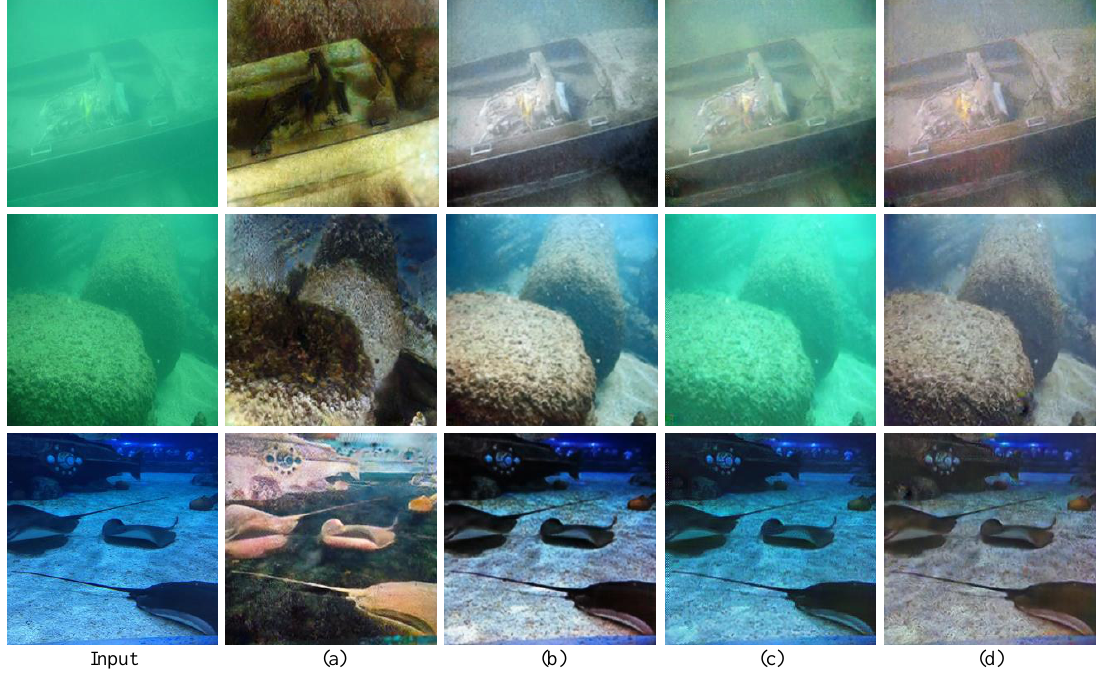
Figure 7. Underwater image enhancement results according to the content discriminators and the adaptive weighting method.